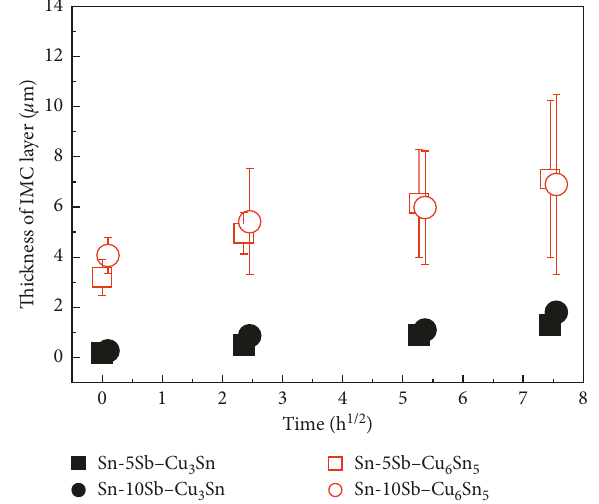
Figure 9: Thickness of IMC layers versus square root of the power cycling time.